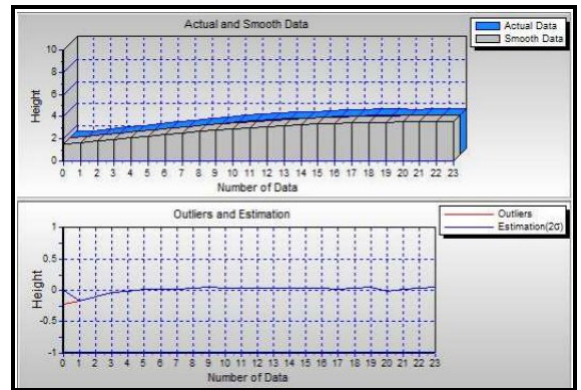
Figure 6. Actual and smoothed data (Top). Outliers and two sigma estimation of tidal data (Bottom)